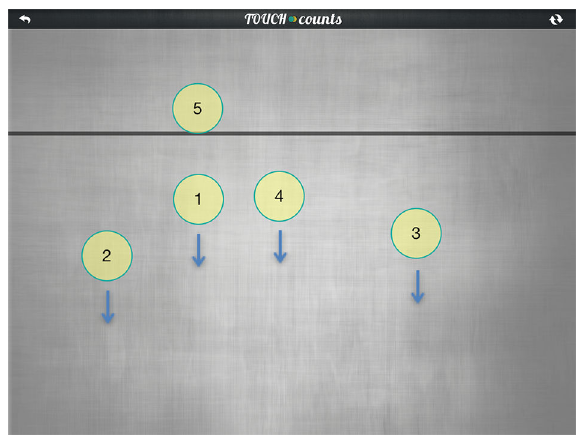
Figure 2. Putting ‘5’ on the